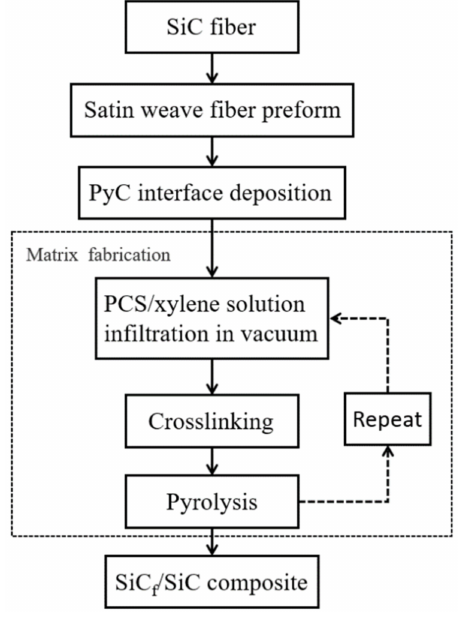
Figure 1. The flowchart of the material preparation.